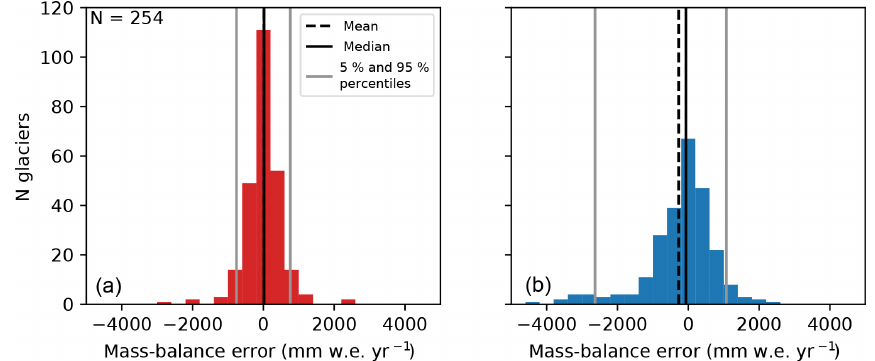
Figure 4. Benefit of spatially interpolating t ∗ instead of µ ∗ as shown by leave-one-out cross-validation ( N = 254). (a) Error distribution of the computed mass balance if determined by the interpolated t ∗ . (b) Error distribution of the mass balance if determined by interpolation of µ ∗ . The vertical lines indicate the mean, median, and 5% and 95% percentiles. See https://cluster.klima.uni-bremen.de/~github/crossval (last access: 27 February 2019) for an online visualization of model performance for each glacier.